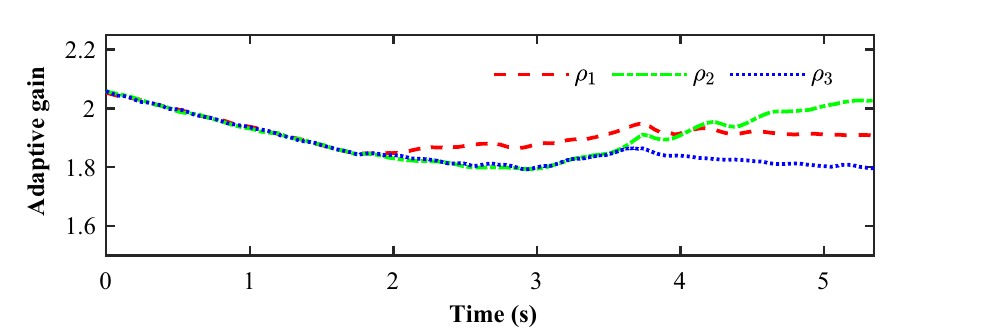
Figure 16. Experimental results: The adaptive switching gain.